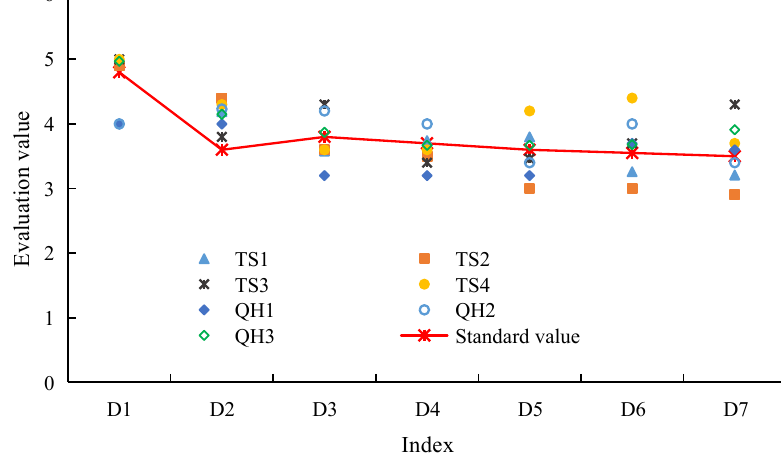
Figure 4. Assessment Map of Seven Kailuan System Projects.